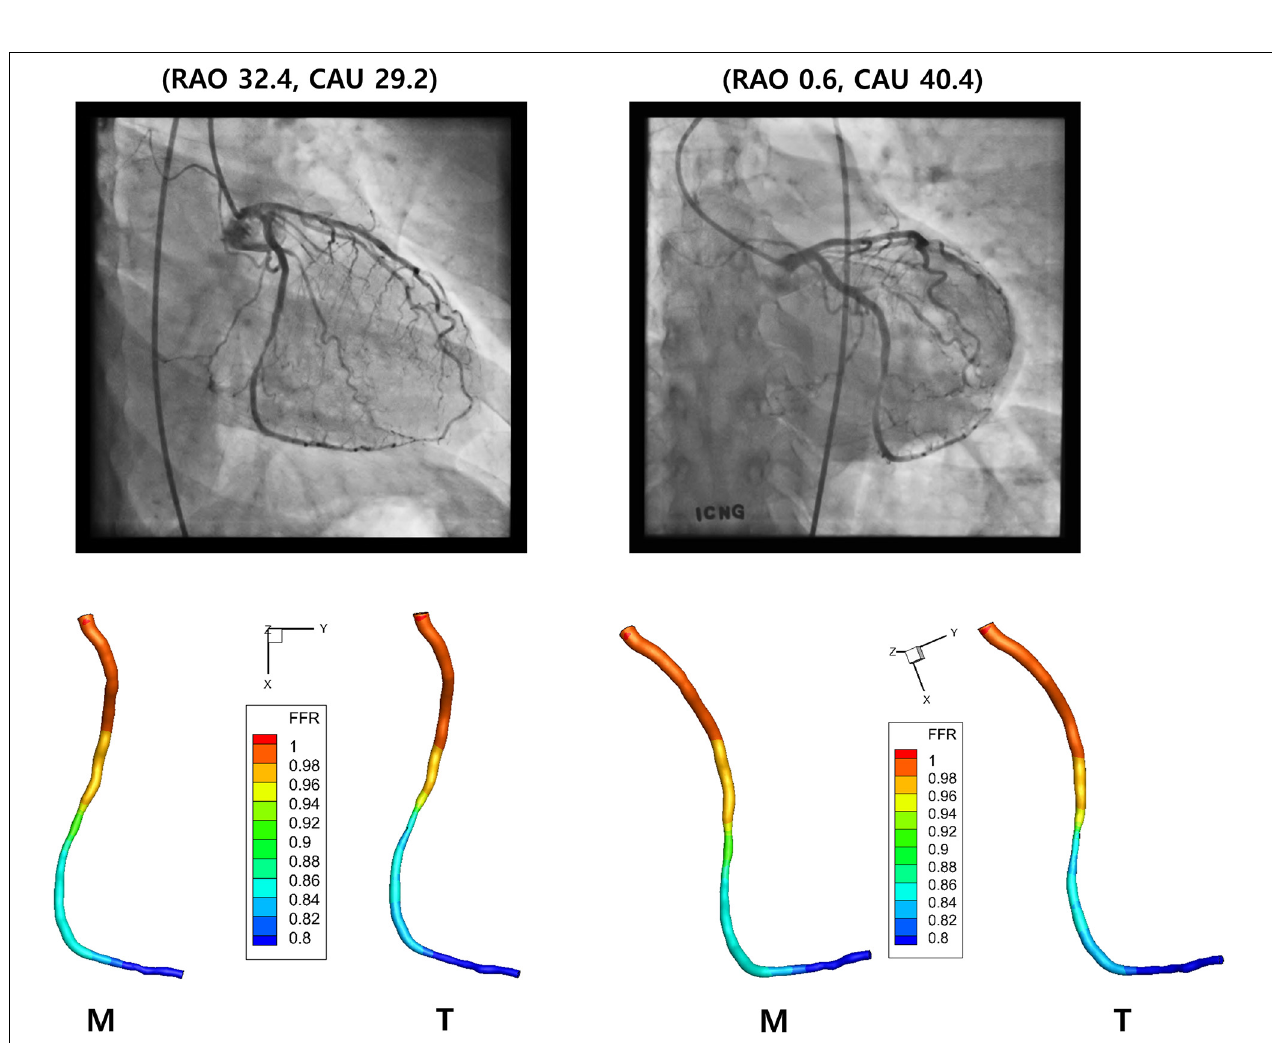
FIGURE 7 | Computed FFR. Distribution of computed FFR is shown for LCX for two different views. Manual (M) and template (T) matchings are compared.